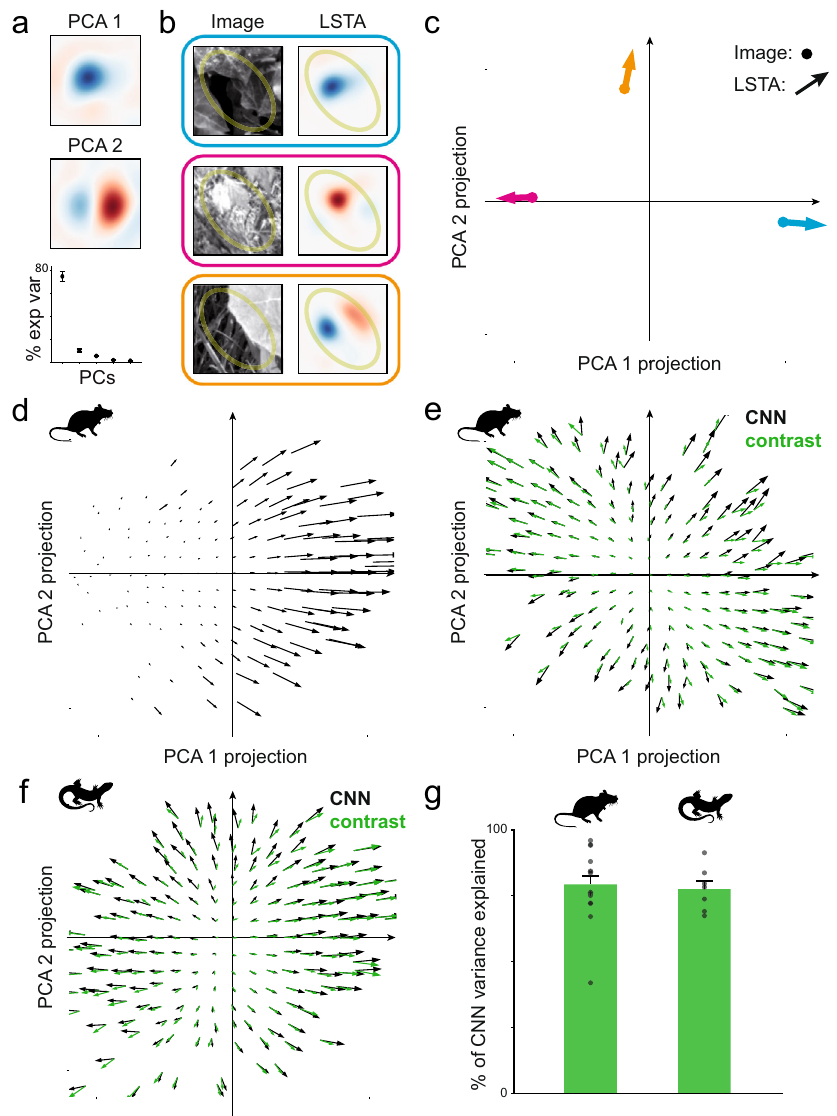
Fig.4|ThereisasystematicrelationshipbetweenimagesandLSTAs.a Foreach cell, we predicted the LSTAs associated with 2910 natural images with the CNN model. We applied PCA on this ensemble of LSTAs for each cell. Top and middle row: the fi rst two PCA components for an example mouse retina ganglion cell. Bottom row: variance of the LSTA ensemble explained by the fi rst fi ve principal components, averaged across all the inverting cells of mouse. b , c Representation of image-LSTA pairs as points and arrows in the two dimensional PCA space representation for the stimulus space. In ( b ) three image-LSTA pairs are color coded into point-arrow pairs. In ( c ) the arrow origins are locatedon the projection of the image in the PCA space and the arrow indicates the projection of the LSTA. d Vector fi eld for an example mouse cell encoding for luminance. The resulting vector fi eld points in the direction of the fi rst principal component (PCA 1, see a ), showing that this cell increases its fi ring rate for decreasing luminance inside the